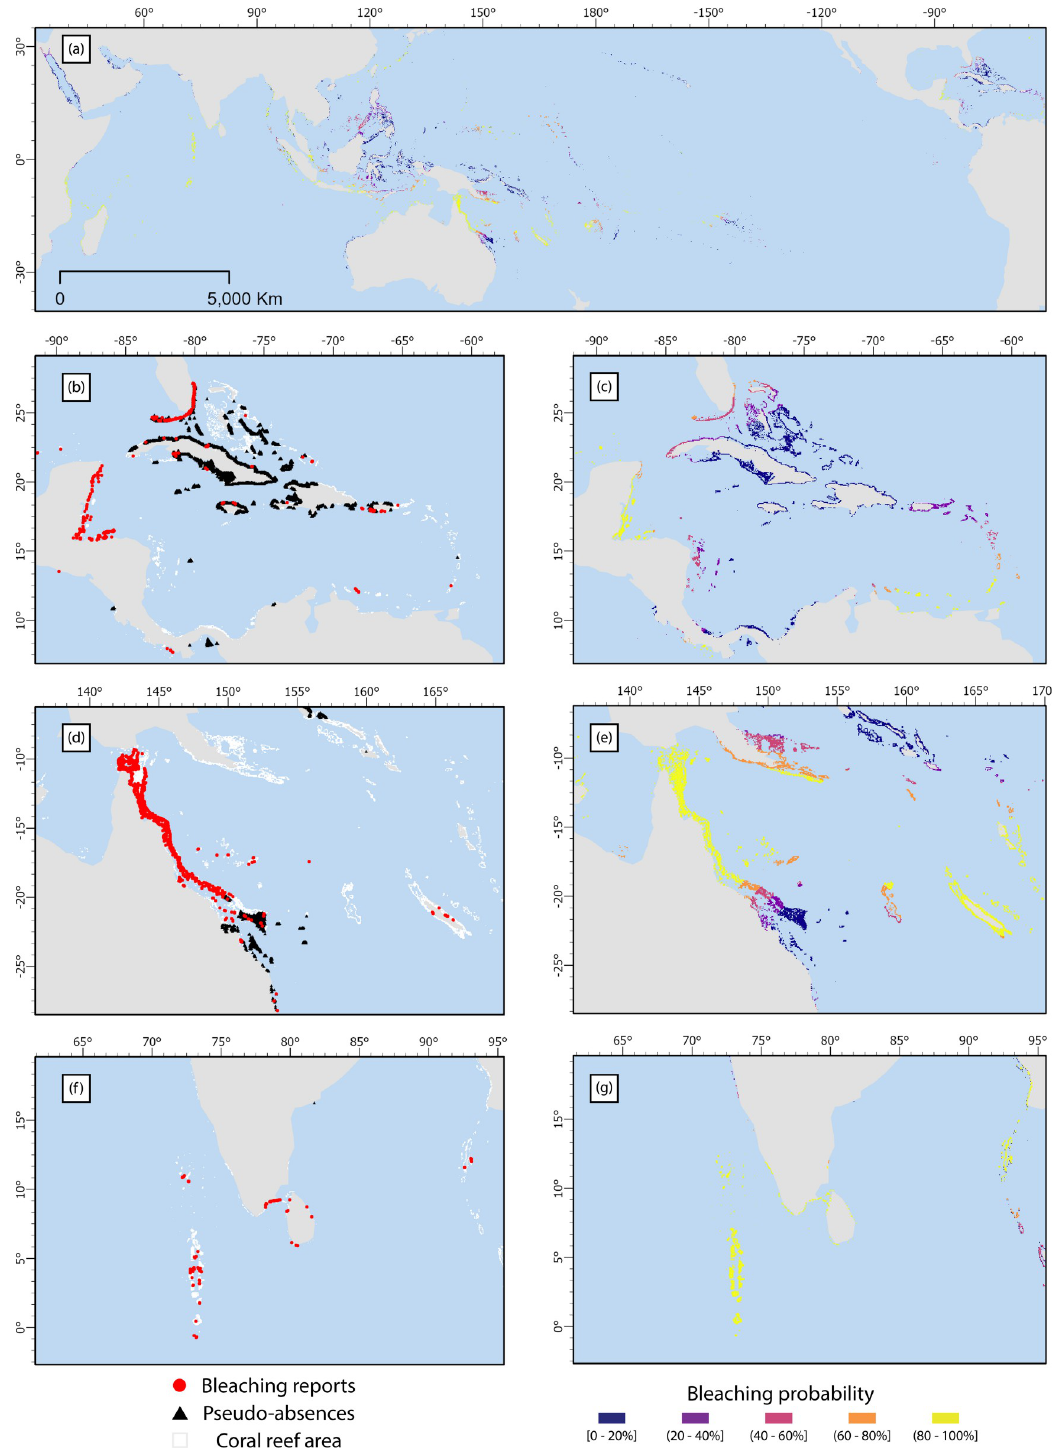
Fig 4. Bleaching probabilities for the year 2015, with insets for selected regions. (a) Global map; (b, d, f) Maps of observed bleaching reports and bleaching pseudo-absences used to inform kriging for the Caribbean, Great Barrier Reef and Central Indian Ocean respectively; (c, e, g) Corresponding maps of bleaching probabilities. Maps are made with the Natural Earth public domain vector and raster map data.